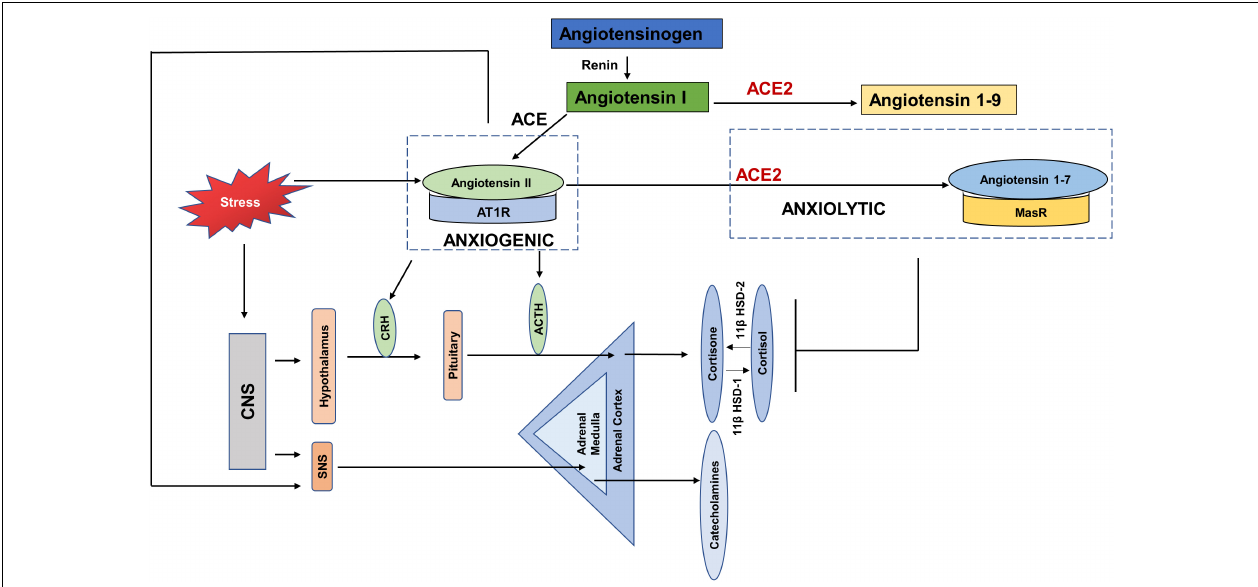
FIGURE 4 | Anxiogenic and Anxiolytic axes of the Renin Angiotensin System (RAS). Increased psychological stress results in increased circulating levels of Angiotensin II, which can increase the adverse effects of Angiotensin II-/AT1R signaling. Angiotensin II/AT1R has been found to increase CRH and ACTH levels, as well as increase SNS tone and thus act as an anxiogenic axis. ACE2-/Angiotensin 1–7/MasR is found to be anxiolytic by dampening the HPA axis activation in response to stress. CNS-(Central Nervous System, CRH (Corticotropin releasing hormone), ACTH (Adrenocorticotropic hormone), SNS (Sympathetic nervous system), 11 β HSD-1 (11 β hydroxysteroid dehydrogenase type 1), 11 β HSD-2 (11 β hydroxysteroid dehydrogenase type